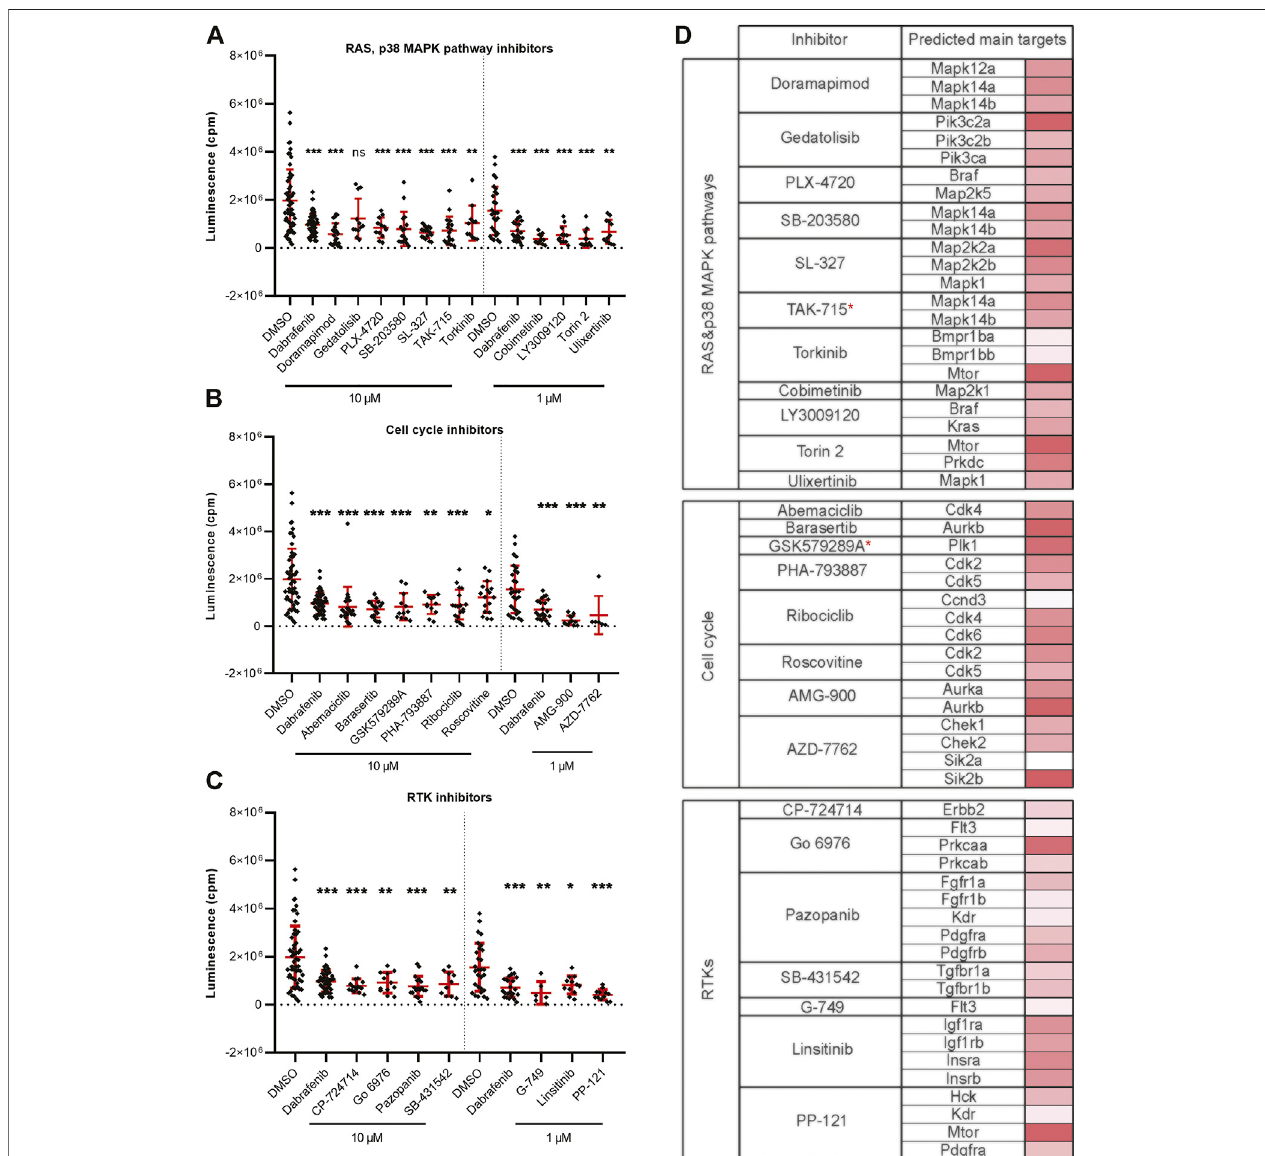
FIGURE3| KinaseinhibitorsactiveintransplantedZMEL1melanomacells. (A) InhibitorsthattargetedtheRASandp38MAPKpathwaysandsigni fi cantlyinhibited melanoma cell growth in vivo . (B) Inhibitors that targeted cell cycle related proteins and signi fi cantly inhibited melanoma cell growth in vivo . (C) Inhibitors that targeted receptor tyrosinekinases (RTKs) and signi fi cantlyinhibited melanoma cellgrowth invivo . (A – C) Statistical signi fi cance wasdeterminedbyMann-Whitneytest. * p < 0.04, ** p < 0.002, *** p < 0.001. Luminescence measured in vivo in single embryos is represented by a single dot in dot plots. All experiments were done in 2 – 3 repeats. (D) List of all the inhibitors from A-C with their predicted main protein targets in zebra fi sh ZMEL1 cells. The last column with red bars on the right represents the average expression of individual target genes in zebra fi sh cells which was extracted from a publicly available RNA-sequencing dataset. Inhibitors with a potent new function in melanoma are labeled with a red